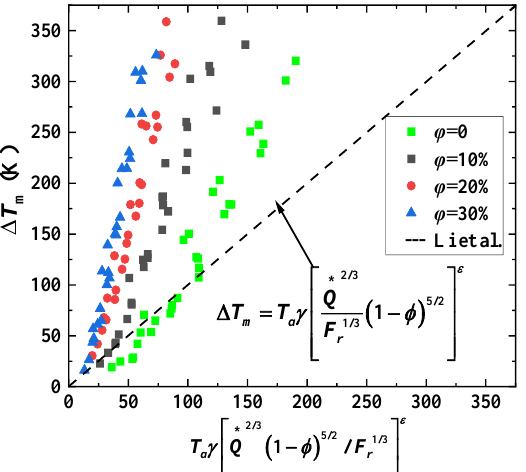
Figure 15. Comparison between the Li’s model and the experimental data considered in this study.